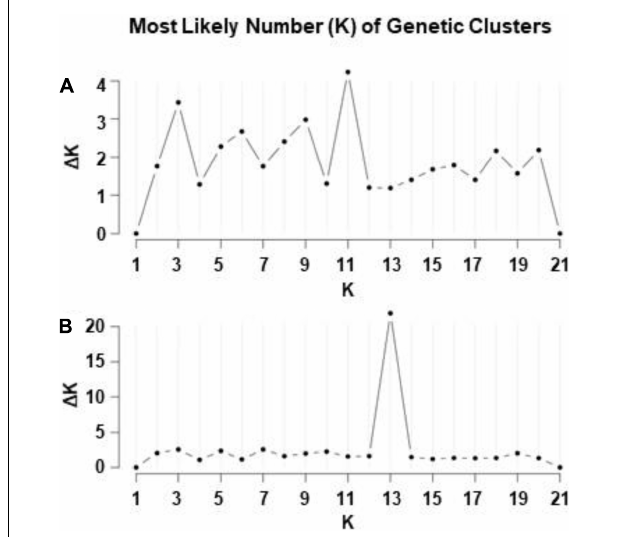
FIGURE 6 | Evanno et al. (2005) (cid:49) K statistics according to ISSR (A) and RAPD (B) markers for 21 populations of Impatiens parviflora .